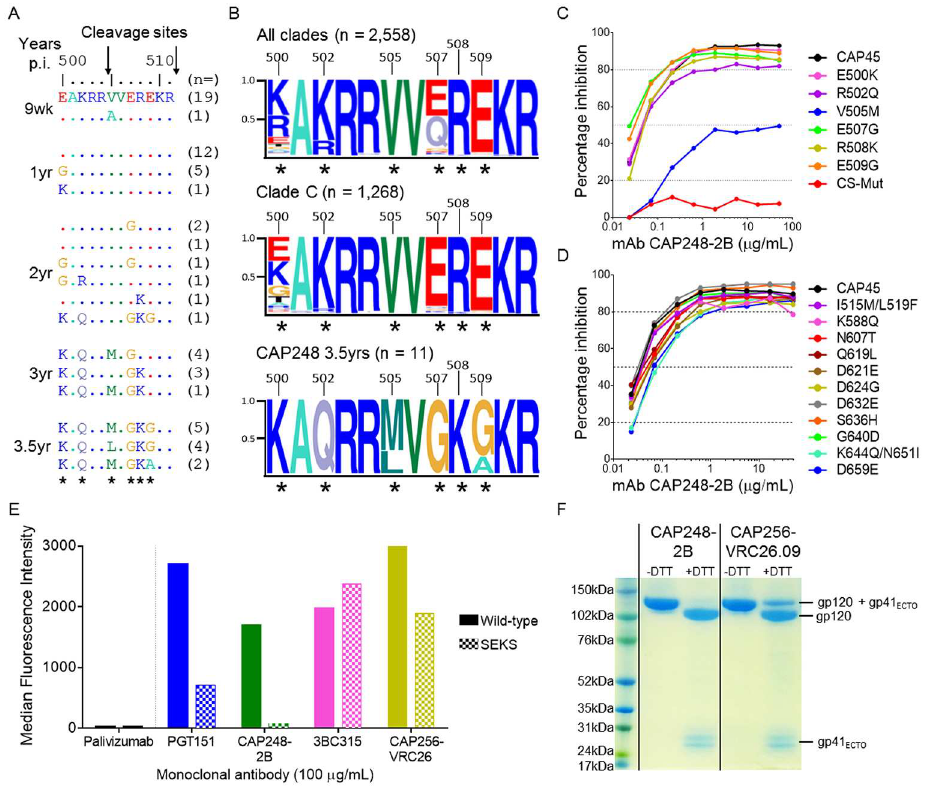
Fig 2. Escape mutations from CAP248-2Baccumulate in the gp120 C terminus. (A) Sequencealignment of the gp120 C-terminus (positions500–511)from CAP248autologousviruses at nine weeks (study enrolment), 1, 2, 3 and 3.5 years post-infection. The primary (position511) and secondary (position 504) gp160 cleavagesites are indicatedwith arrows. The total number of viruses with identicalamino acid sequencewithin this regionare indicatedin brackets to the right. Residuesundergoingsignificantselection pressureare indicatedwith the asterisks. (B) Sequence logogramsshowingvariation within the gp120 C- terminus for all clades, and clade C only, from the LANL HIV sequencedatabase, as well as from CAP248-2B at 3.5 years post-infection, coloredand labelledas in A. The globalfrequencies for each of the autologous mutations identified in CAP248 sequenceswere: 500 (E8.88%, K46.56%, G3.56%), 502 (K79.35%, R18.73%,Q1.37%), 505 (V98.98%, A0.55%, M0.08%,L < 0.01%),507 (E47.5%, G3.87%, A0.7%), 508 (R98.24%, K1.49%), 509 (E95.11%, G1.53%, A0.27%). (C) Neutralization by CAP248-2B of the heterologous strain CAP45, when comparedto gp120 C-terminal mutant viruses with changesidentified from autologous CAP248Env sequences.Data was plotted as percent inhibition(y-axis) againstantibody concentration (x- axis). The wild-typevirus is shown in black. Dotted lines indicate y-axis intersections for IC 80 , IC 50 , and IC 20 . (D) Neutralization by CAP248-2Bof CAP45 wild-typeand mutant viruses with the additionalgp41 changes identifiedfrom CAP248autologoussequences, plotted as in C. (E) Bindingto cleaved(solid bars) or uncleaved(speckledbars) cell-surface expressedEnv measuredby flow cytometry. Medianfluorescence intensity (MFI) is shown on the y-axis, and Palivizumab was used as an HIV-1 negative control. (F) An SDS-PAGE gel of a singleSOSIP trimer sample that was dividedinto two and subsequently capturedfrom suspension by either CAP248-2Bor CAP256-VRC26.09.Sampleswere run in the presenceor absenceof dithiothreitol (DTT) to assess the level of furin